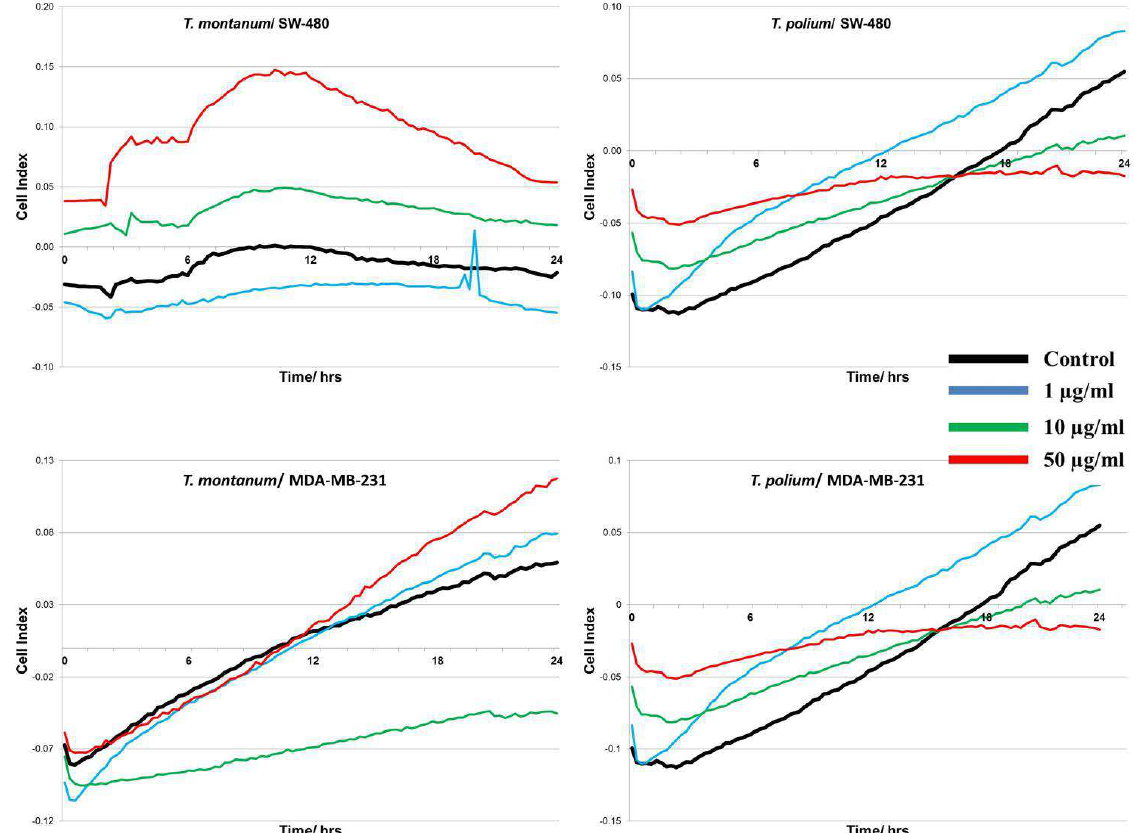
Figure 1. Effects of Т eucrium montanum and Т . polium extracts on migration of SW-480 and MDA-MB-231 cell